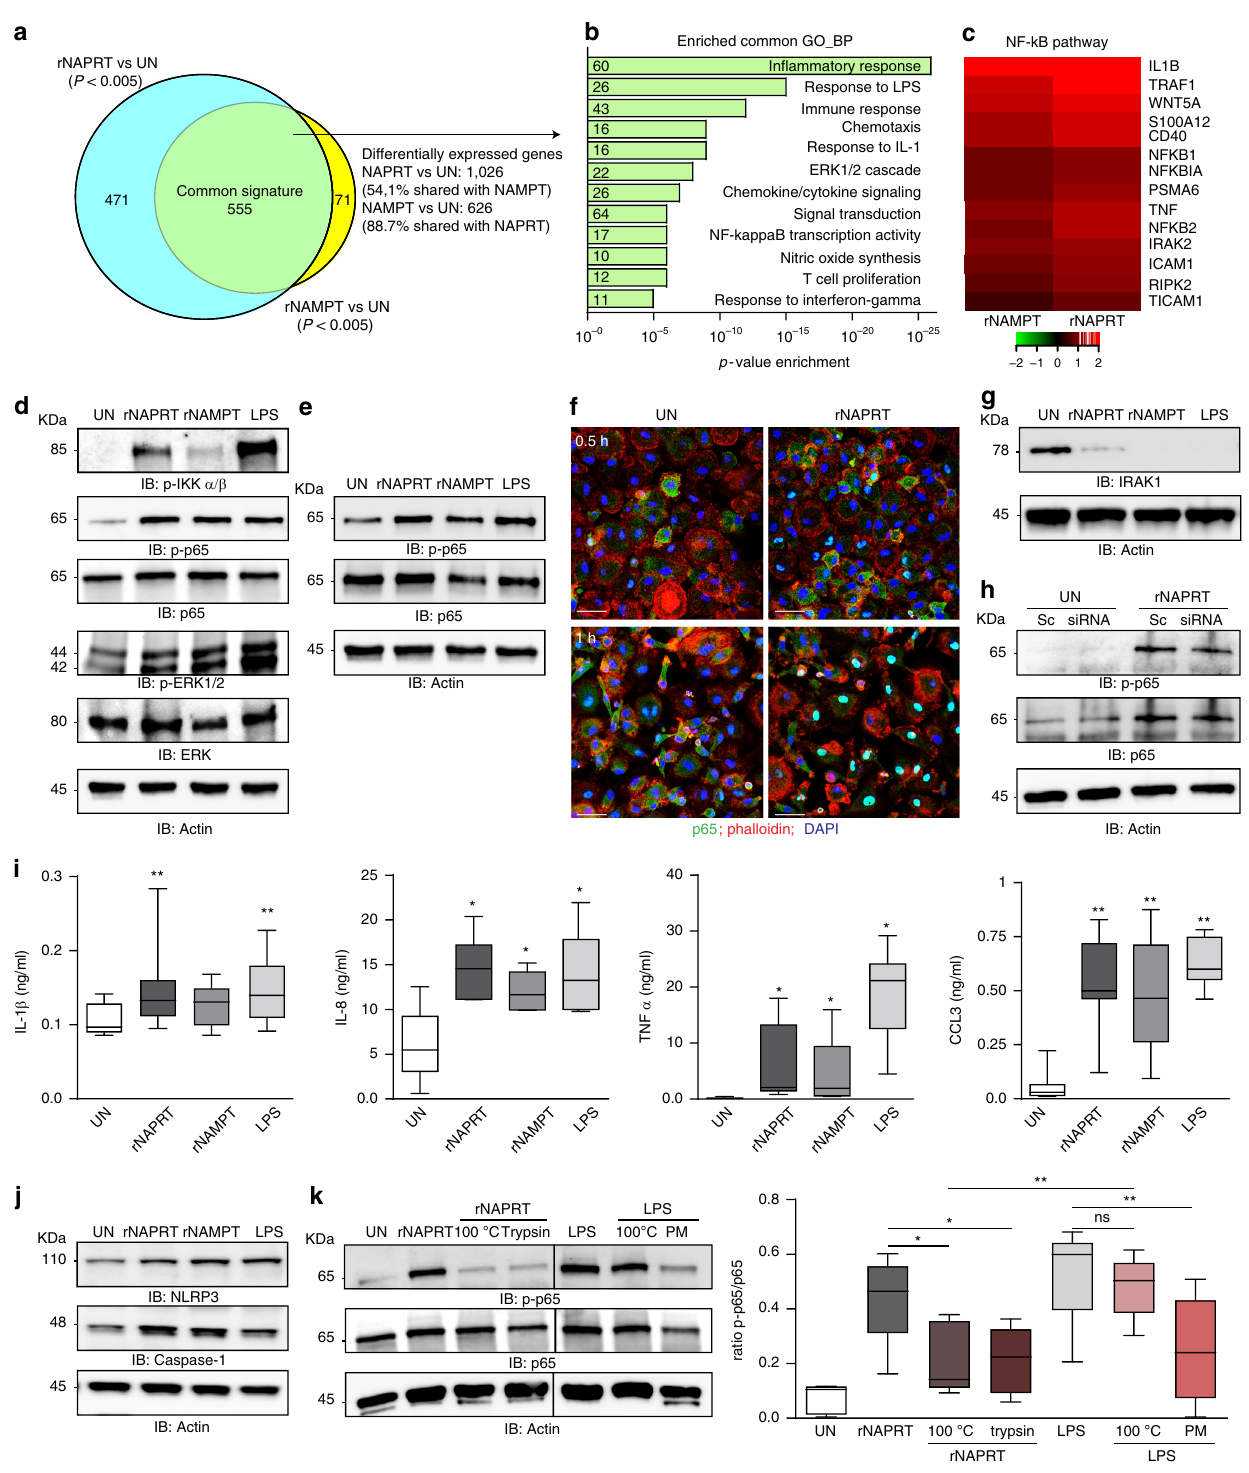
eNAPRT forces monocyte differentiation into macrophages . rNAPRT and rNAMPT modulated genes encoding for cytokines and chemokines involved in myeloid-macrophage differentiation, including the colony-stimulating factors ( CSF1,2,3 ). These cyto- kines, in particular CSF1 /M-CSF, induce differentiation of hematopoietic stem cells and circulating monocytes into macro- phages, controlling their polarization, phagocytosis, and chemo- taxis 31,32 . We con fi rmed signi fi cantly increased M-CSF transcription and secretion upon treatment of normal